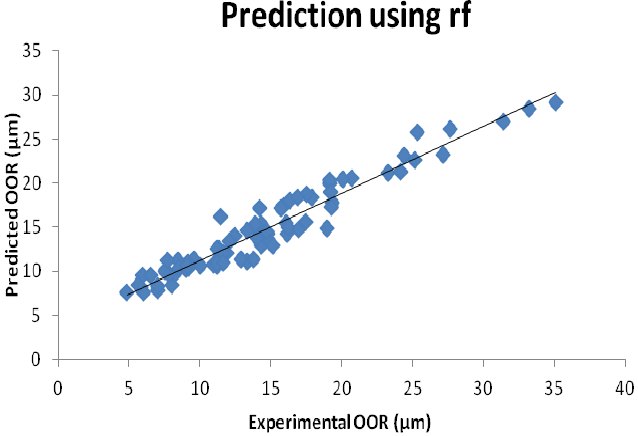
Figure 8. Experimental versus predicted change in out-of-roundness using the random forest tech- nique.